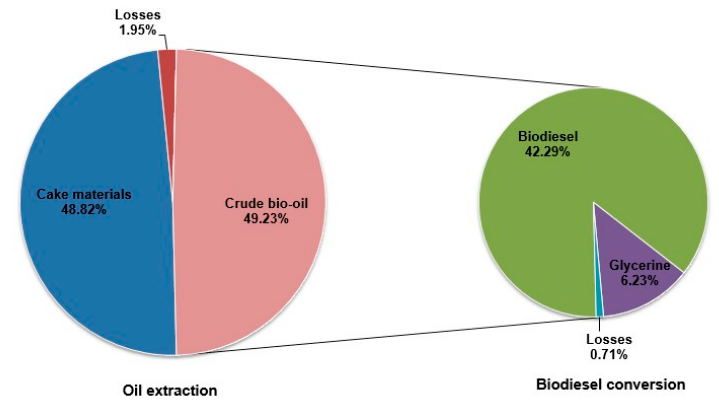
Figure 12. Mass balance for the total process (oil extraction and biodiesel conversion).